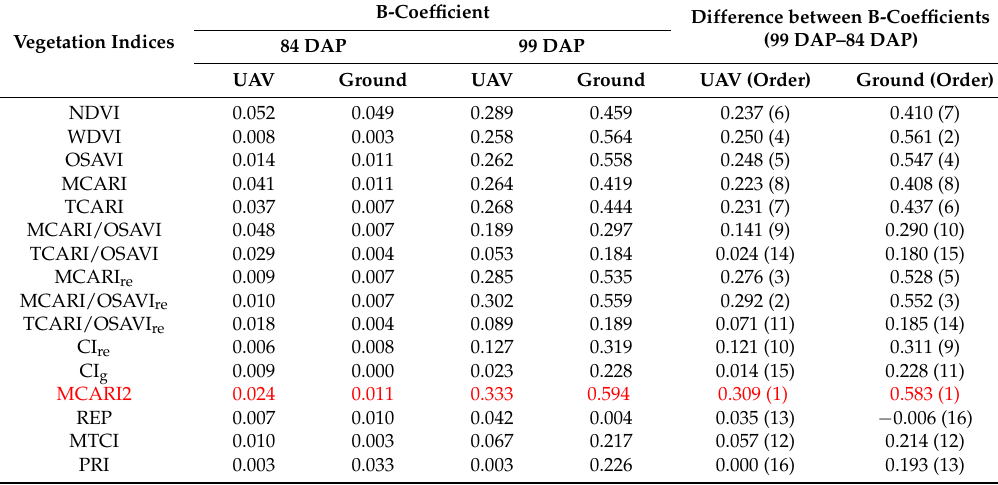
Table A2. Bhattacharyya coefficient (B-coefficient) between distributions of vegetation indices, calculated from UAV and ground-based measurements, corresponding to each production system (i.e., non-mixed and mixed varieties). Only values calculated for the two last data acquisitions (84 and 99 days after planting—DAP) are presented. The index giving the best treatments distinction (i.e., largest B-coefficients) for both sensor systems is indicated in